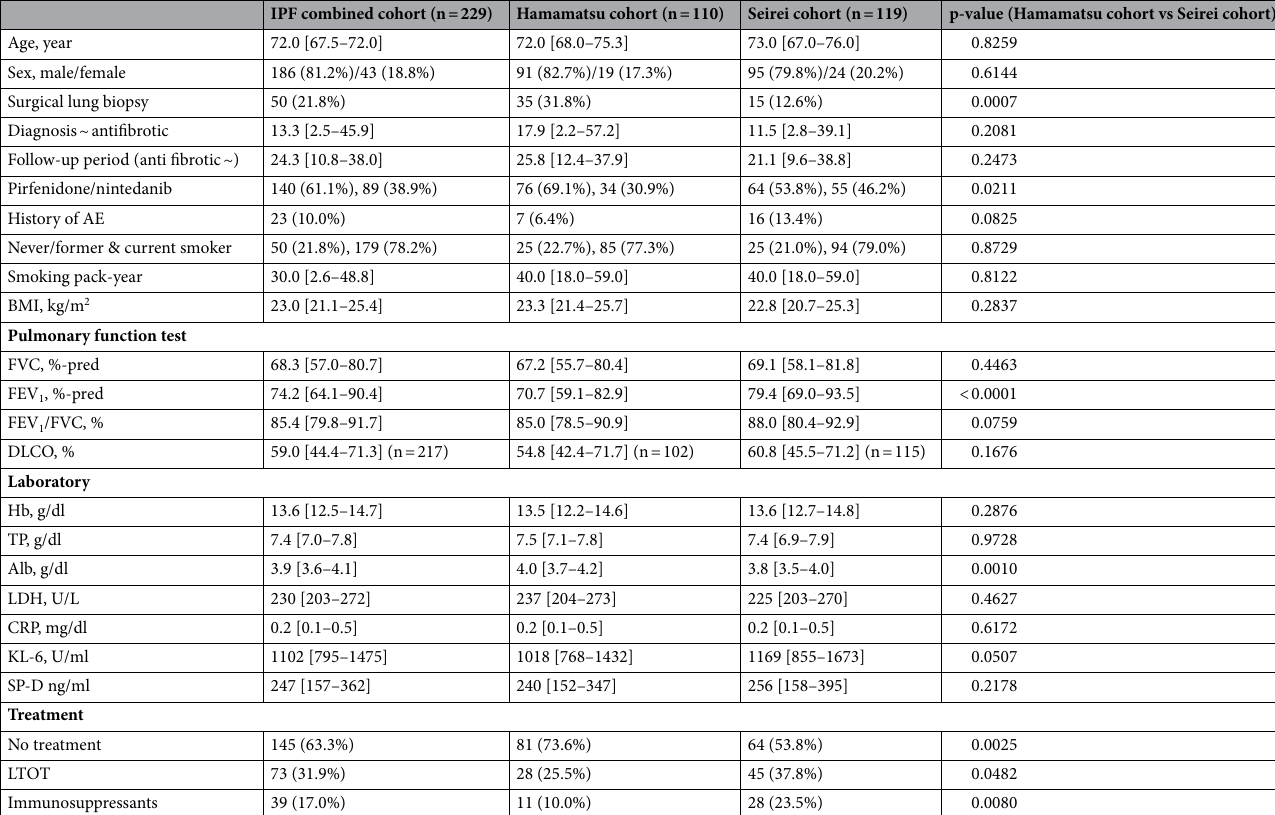
Table 1. Clinical characteristics of 229 patients with IPF at initiations of antifibrotic therapy. AE acute exacerbation, BMI body mass index, FVC forced vital capacity, FEV 1.0 forced expiratory volume in 1.0 s,